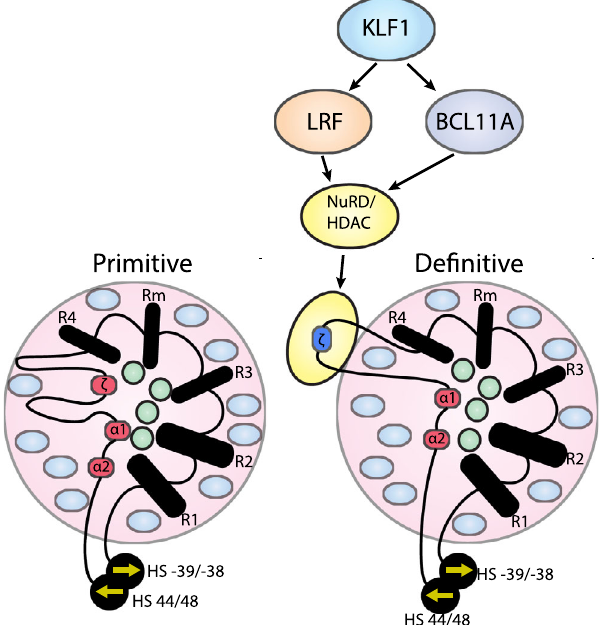
Fig. 8 Model of ζ -globin activation and repression. LRF and BCL11A both interact via the NuRD complex leading to ζ -globin hypoacetylation and silencing in de fi nitive (adult) erythroid cells and are regulated upstream by KLF1 15 . Pink circles represent the domain of H3K27 acetylation, green circles, and blue ovals represent transcriptional activators and repressors respectively. The yellow oval indicates a separate compartment containing the hypoacetylated region containing the ζ -globin gene. HS-39/HS-38 and HS44/48 refer to the CTCF sites known to be involved in the formation of the α -globin domain 19 and the arrows indicate directionality, see main